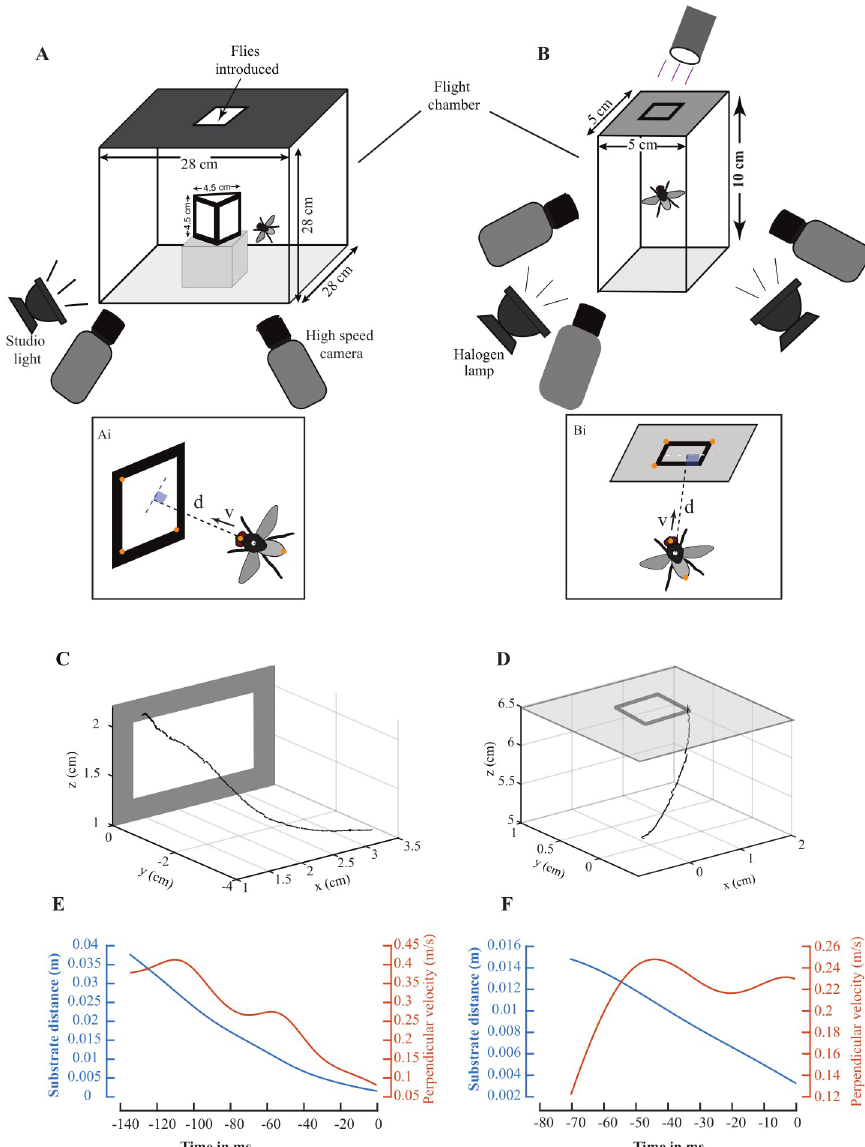
Fig 1. Experimental setups to record wall and ceiling landings, and measurement of the associated flight variables. Experimental setup for filming (A) wall landings elicited on a prism-shaped object and recorded using two synchronized high-speed cameras at 3000 fps, and (B) ceiling landings on a translucent ceiling recorded by three synchronized high-speed cameras at 4000 fps. For both vertical (Ai) and ceiling landings (Bi), we digitized tips of head and abdomen of fly in each frame, and three points on the landing substrate, and computed the midpoint of the line joining head and abdomen tips, and the distance of the midpoint from substrate (d). Flight velocity perpendicular to the plane of substrate (v) was computed using Equation 1. (C-D) Sample raw trajectories of the midpoint of a fly performing a vertical (C) and ceiling landing (D). (E-F) Below each trajectory, the substrate distance (blue) and perpendicular velocity (orange) are plotted against time-to-landing. Flies contacted the landing surface at 0 ms. most trials, flies took off from a lateral wall, rotated about their longitudinal axis (roll) by almost 360˚, before ascending towards the ceiling. The video frame in which roll rotation ended was chosen as the start-point and the frame of first contact with substrate as end-point of each video.